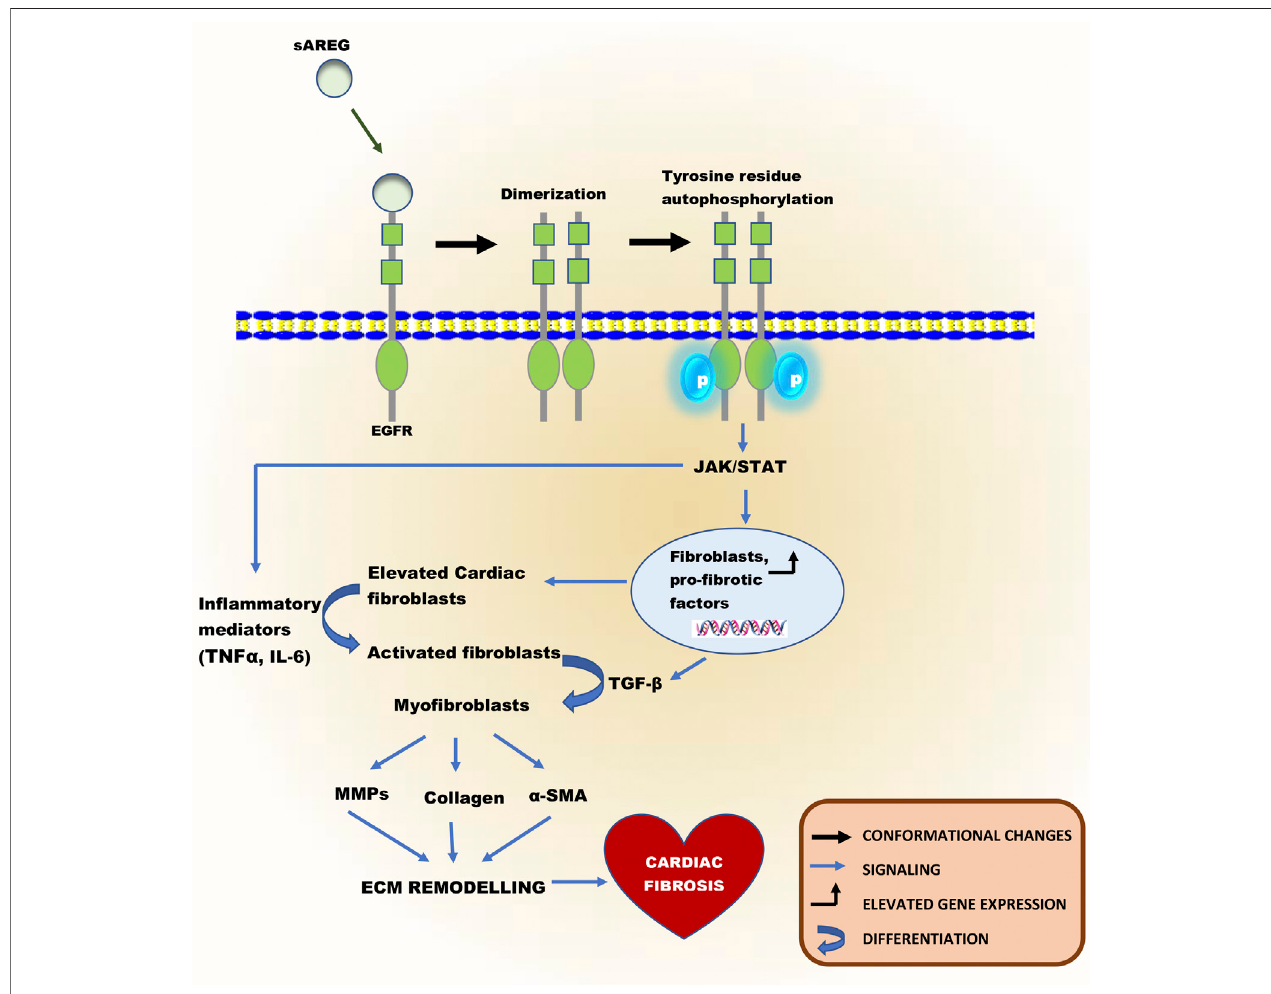
FIGURE4| Schematicillustrationofthe fi broticroleofsAREG,asubstrateofADAM17.AftertheproteolyticprocessofADAM17,sAREGcanactivateEGFR,which is widely expressed on cardiac cells. The binding of sAREG to EGFR causes the receptor to undergo a conformational change known as “ Dimerization, ” resulting in homo- or heterodimers formation. This precedes an intracellular domain activation in its tyrosine residues by phosphorylation, promoting these same residues ’ autophosphorylation in their homolog. Autophosphorylation of EGFR can activate it to induce the JAK/STAT pathway, leading to an increase in gene and protein expression of fi broblasts and pro- fi brotic factors such as TGF- β . Elevated fi broblasts can result in fi broblast activation, both mechanically by altered activation patterns and chemically by in fl ammatory mediators. Activated fi broblasts are transformed into myo fi broblasts by TGF- β . Myo fi broblasts are not present in normal cardiac tissue unless during cardiac injury and can induce pathological ECM remodeling, which characterizes cardiac fi brosis via the expression of α -SMA, collagen synthesis, and secretion of MMPs.